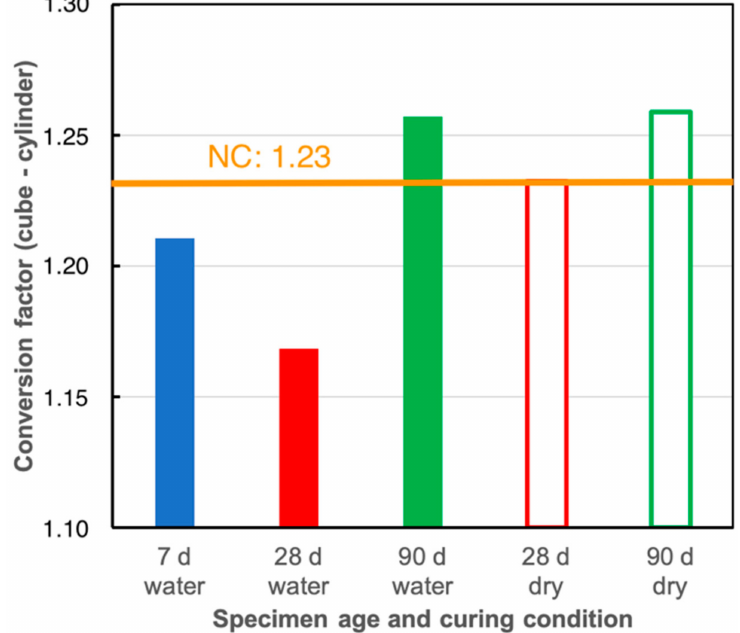
Figure 6. Conversion factors between 150-mm cubes and 300 / 150-mm cylinders for LC tested at 7 d, 28 d and 90 d. The specimens were cured under water [116] or in a climate room (20 ◦ C / 65% relative humidity) following the German national annex to [116]